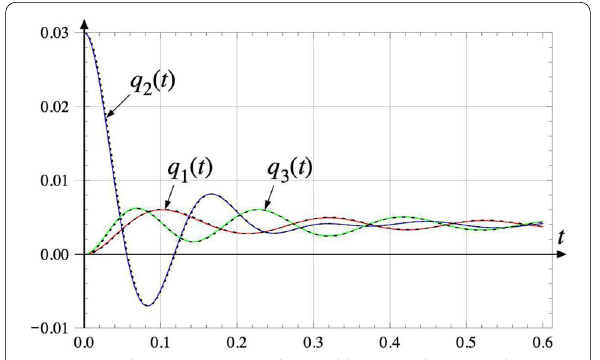
Fig. 3 Free vibration response obtained by using the general methodology. The response q 1 ( t ) , q 2 ( t ) , and q 3 ( t ) are indicated. Note that the initial conditions are satisfied